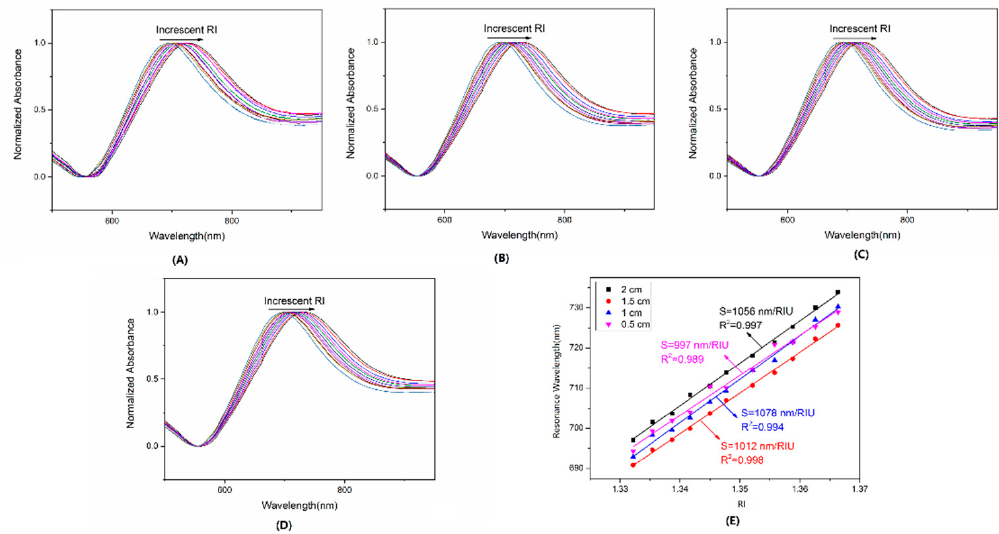
Figure 5. The normalized absorbance spectrum series of fiber sensors in glycerol solutions with different lengths for ( A – D ) 0.5, 1, 1.5, and 2 cm, and ( E ) the linear fitting curves of RI vs. λ p with different lengths.